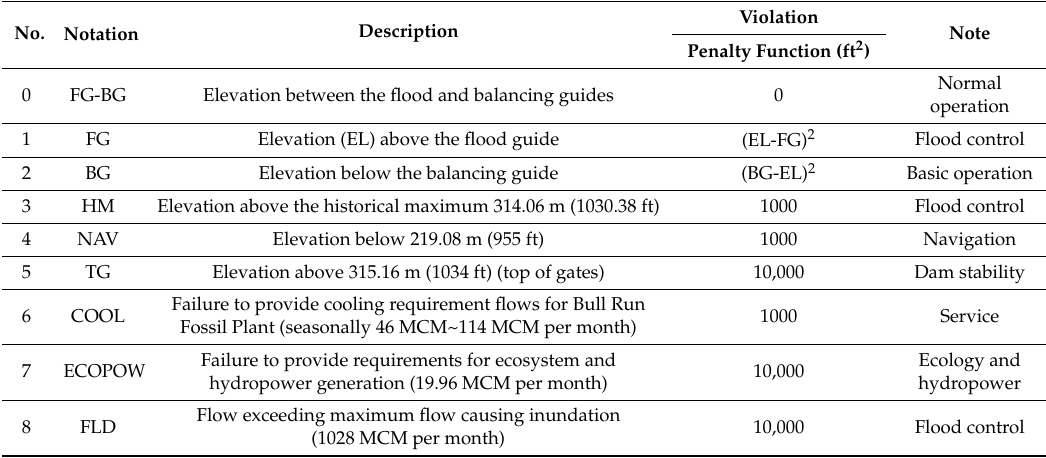
Table 1. Penalty functions in Norris Dam